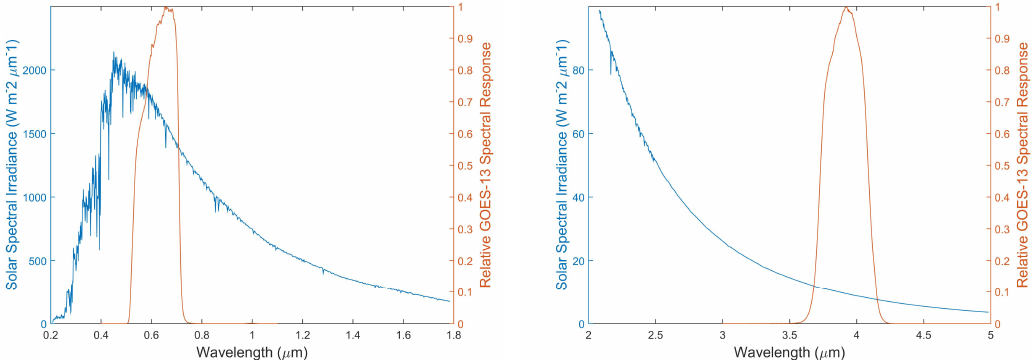
Figure 2. GOES channel spectral response and solar spectral irradiance: ( left ) 0.62 channel; ( right ) 3.9 channel.